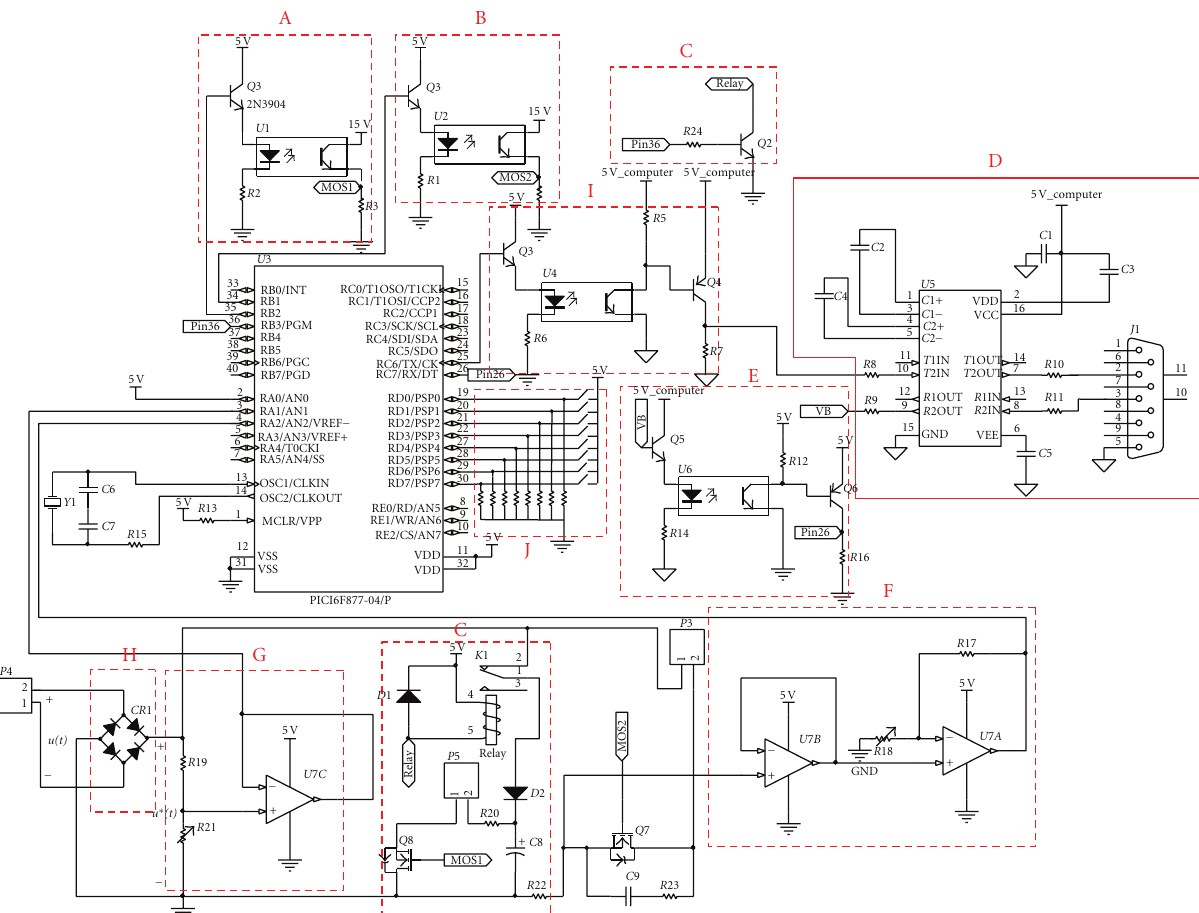
Figure 6: It shows the schematic diagram of a microcontroller-based